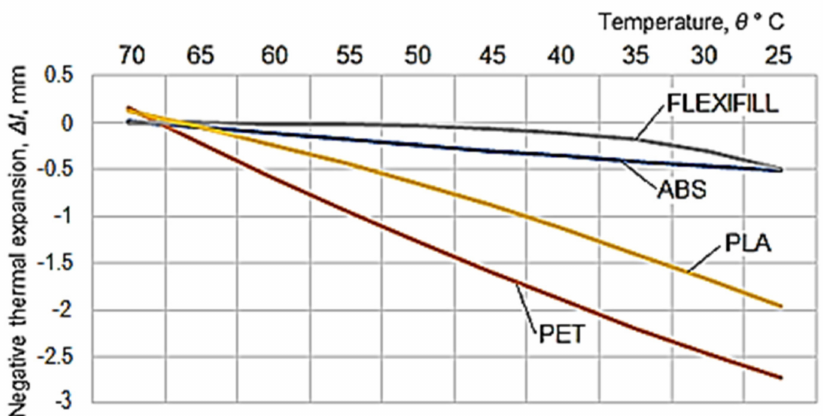
Figure 7. Evolution of negative thermal expansion to the initial temperature, according to the most ap- propriate empirical mathematical models to the experimental results, for the four polymeric